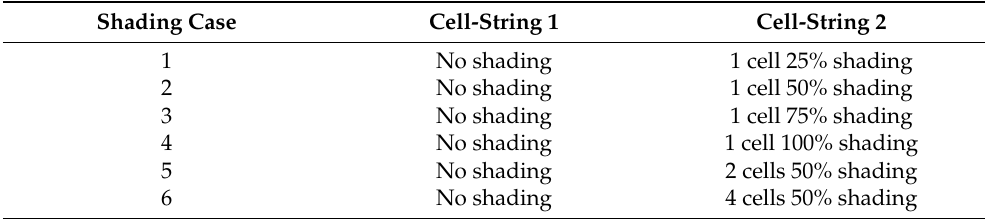
Table 4. The shading cases imposed on a 10 W PV module, consisting of two strings with 18 solar cells in each